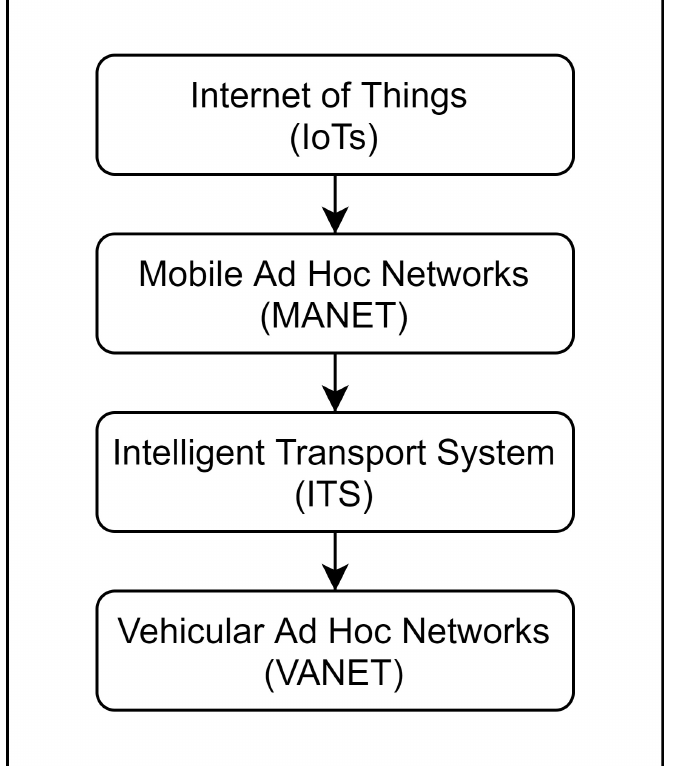
Figure 1. Relationship of IoT and VANET: A hierarchical